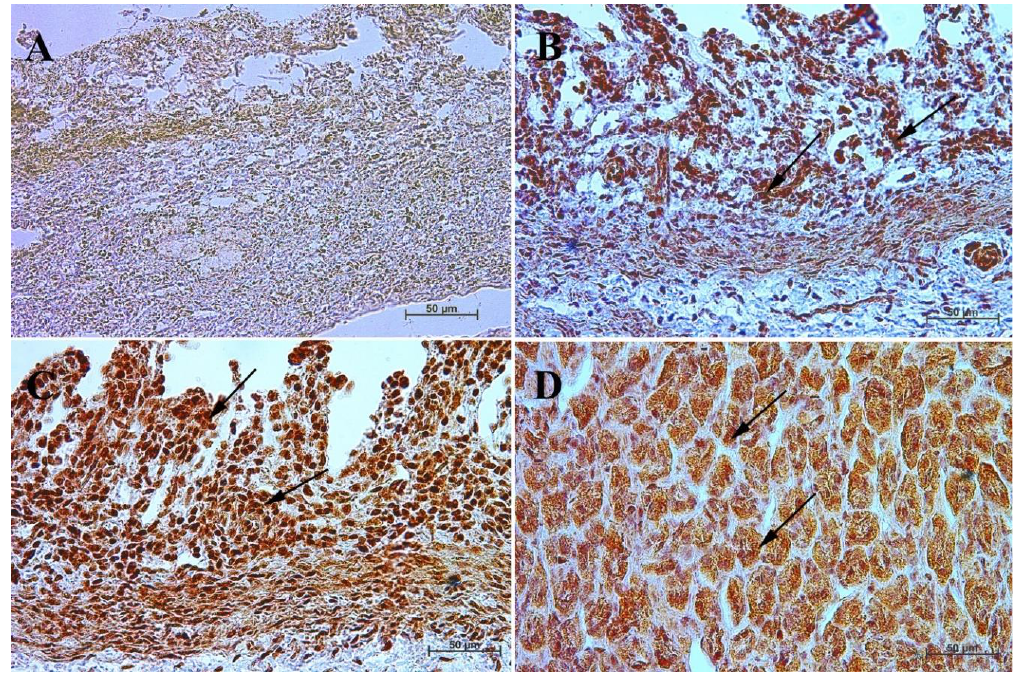
Figure 3. Immunoreactivity of anti-gastrin antibody in the fundic mucosa of the stomach, 40×. ( A ) the first age group, ( B ) the second age group, ( C ) the third age group, ( D ) adult reference group. The arrow indicates positive immunohistochemical reaction.